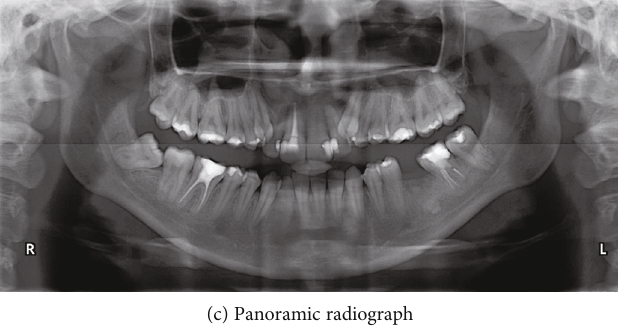
Figure 3: Pretreatment cephalometric and panoramic